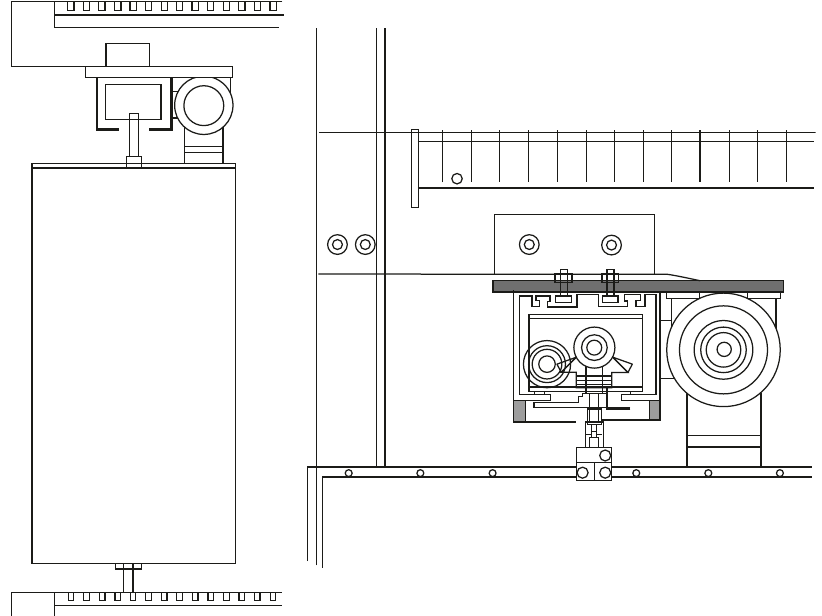
Figure 13: Detailed design of a combined middle axis rotating shaft and horizontal push-and-pull rail (source: authors’ own data).